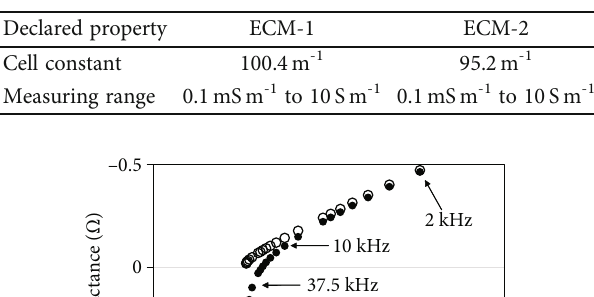
Figure 3: Examples of plotting resistance as a function of inverse frequency (1/ f ) measured by ECM-2 with 1molkg -1 KCl aqueous solution in the frequency range from 2 kHz to 100 kHz.